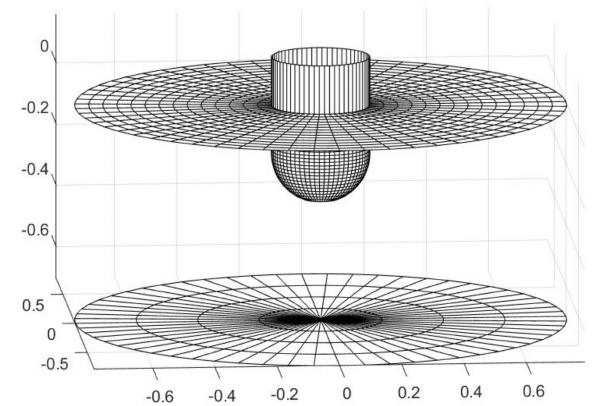
Figure 9. Mesh of the present 3D BEM of a floating WEC with main dimension ratios: R w / h = 0.225, d / h = 0.45, indicatively including the bottom surface at depth h = 0.7 m below the calm water